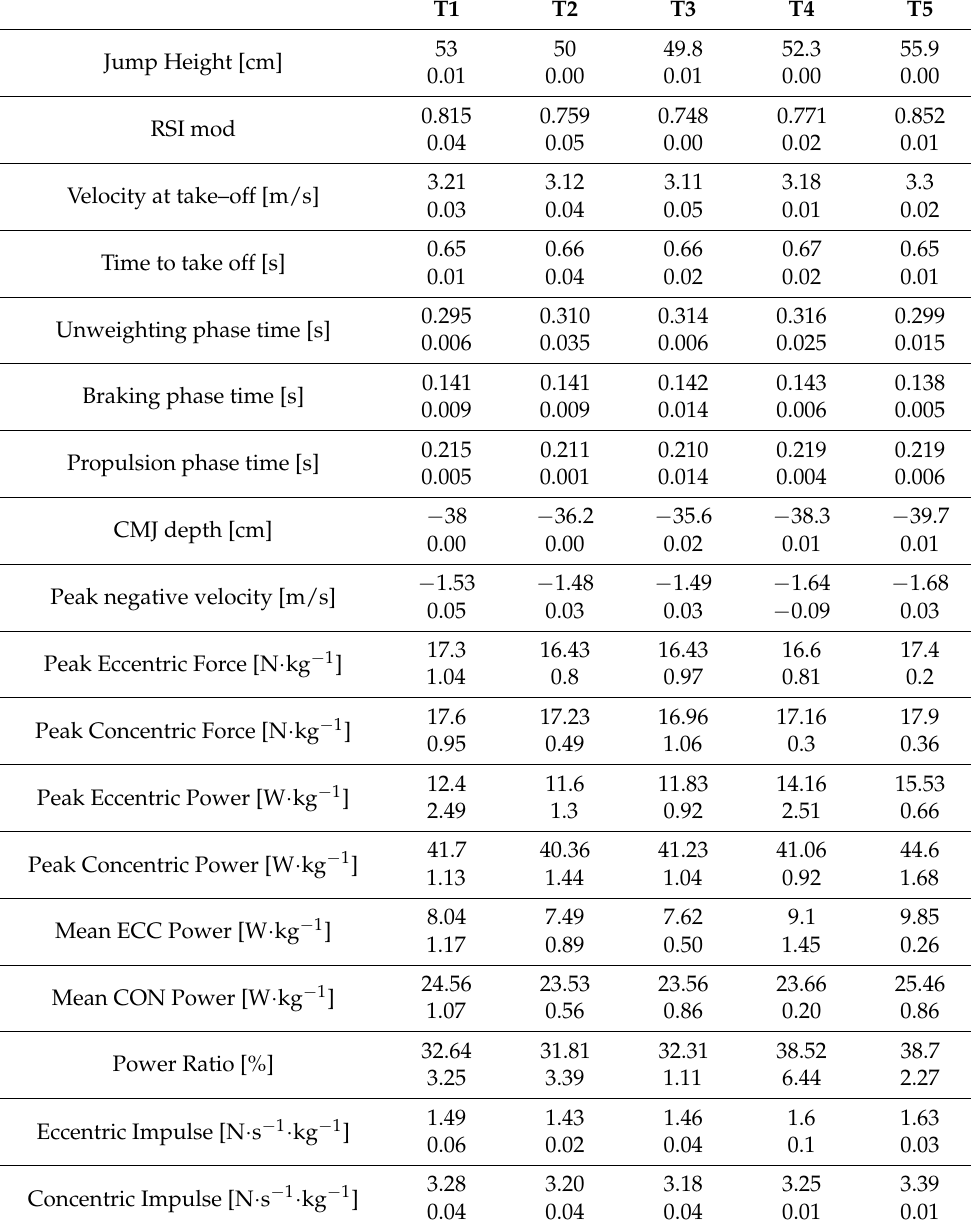
Table 8. Countermovement jump kinetic and kinematic data across 16